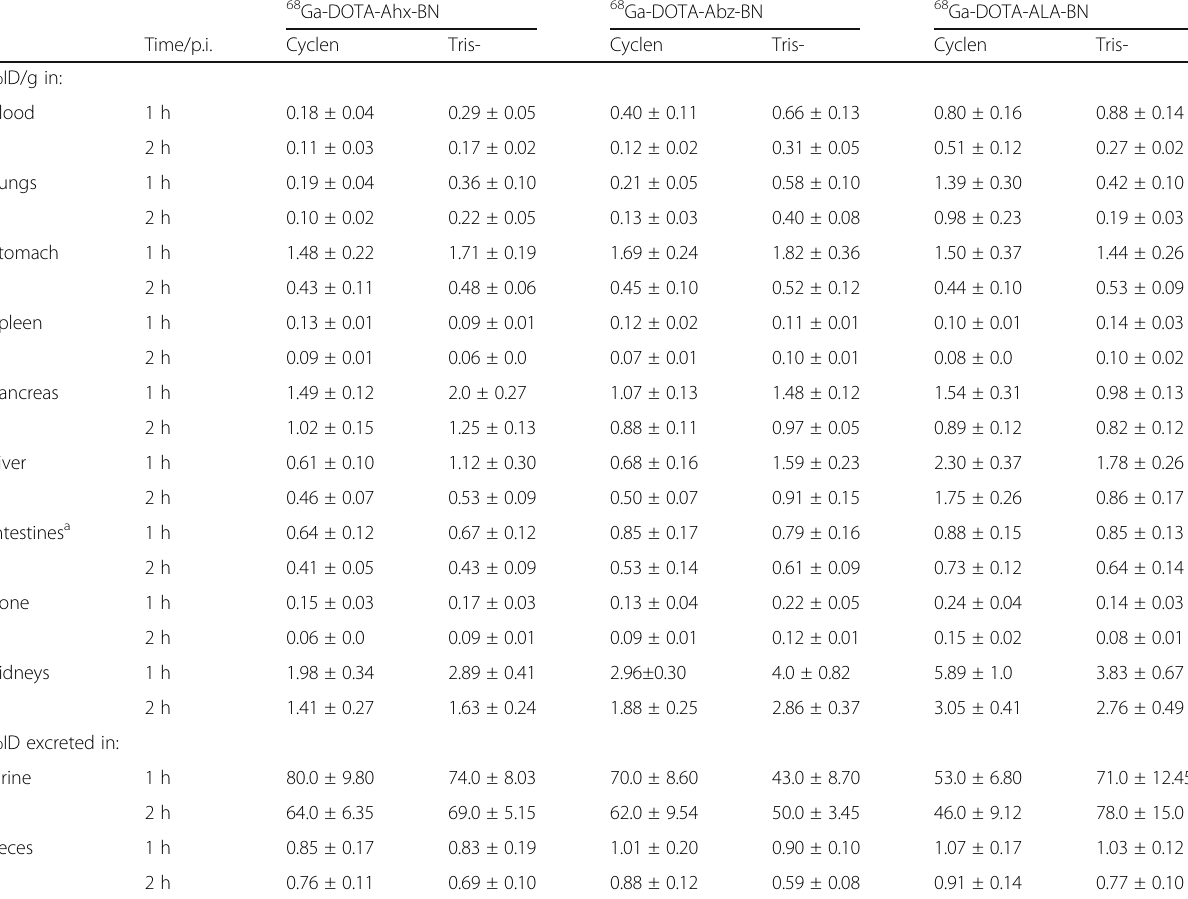
Table 3 In vivo biodistribution of 68 Ga-DOTA-labeled BN peptides in Balb/c mice at 1 h and 2 h post-injection ( n = 3-5). Data are expressed as % injected dose per gram of tissue (mean values ± SD). Urinary excretion values (% injected dose) were calculated by measuring the radioactivity associated with the excreted urine and bladder contents at the time of sacrifice at 1 and 2 h post- injection 68